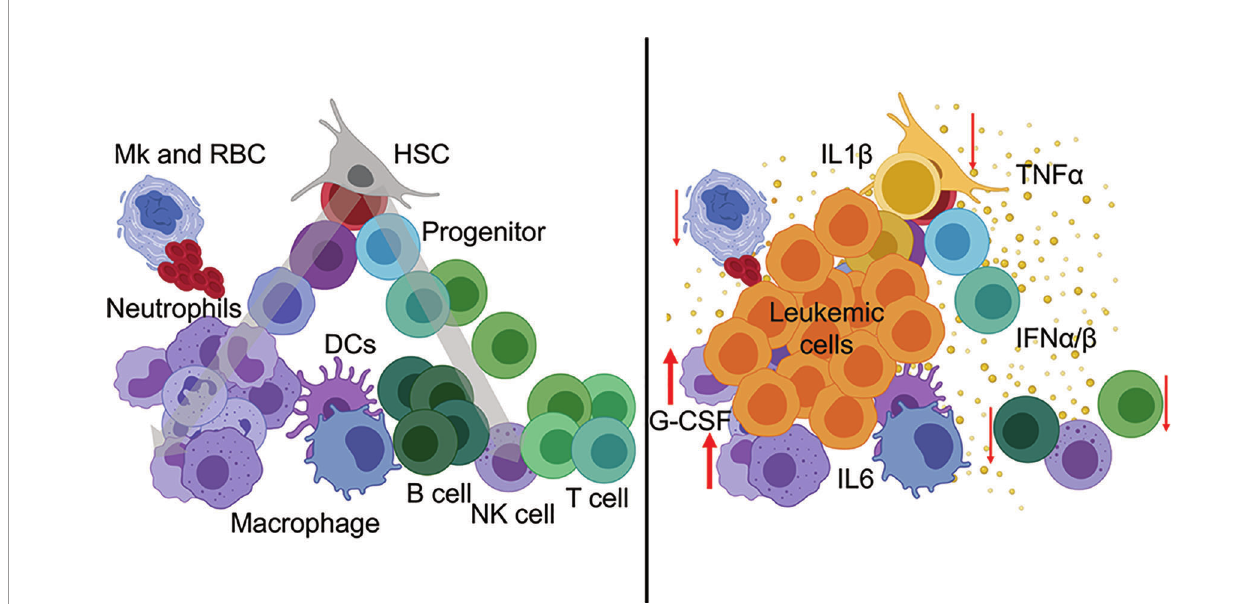
FIGURE 1 | Hematopoietic perturbation from in fl ammatory cytokines during leukemia. (Left) Normal hematopoiesis is a continuous process from stem cells (top) through mature immune lineages (bottom). (Right) Leukemia-associated in fl ammatory cytokines mediate the differentiation, abundance, and cellular functions of innate and adaptive immune populations during